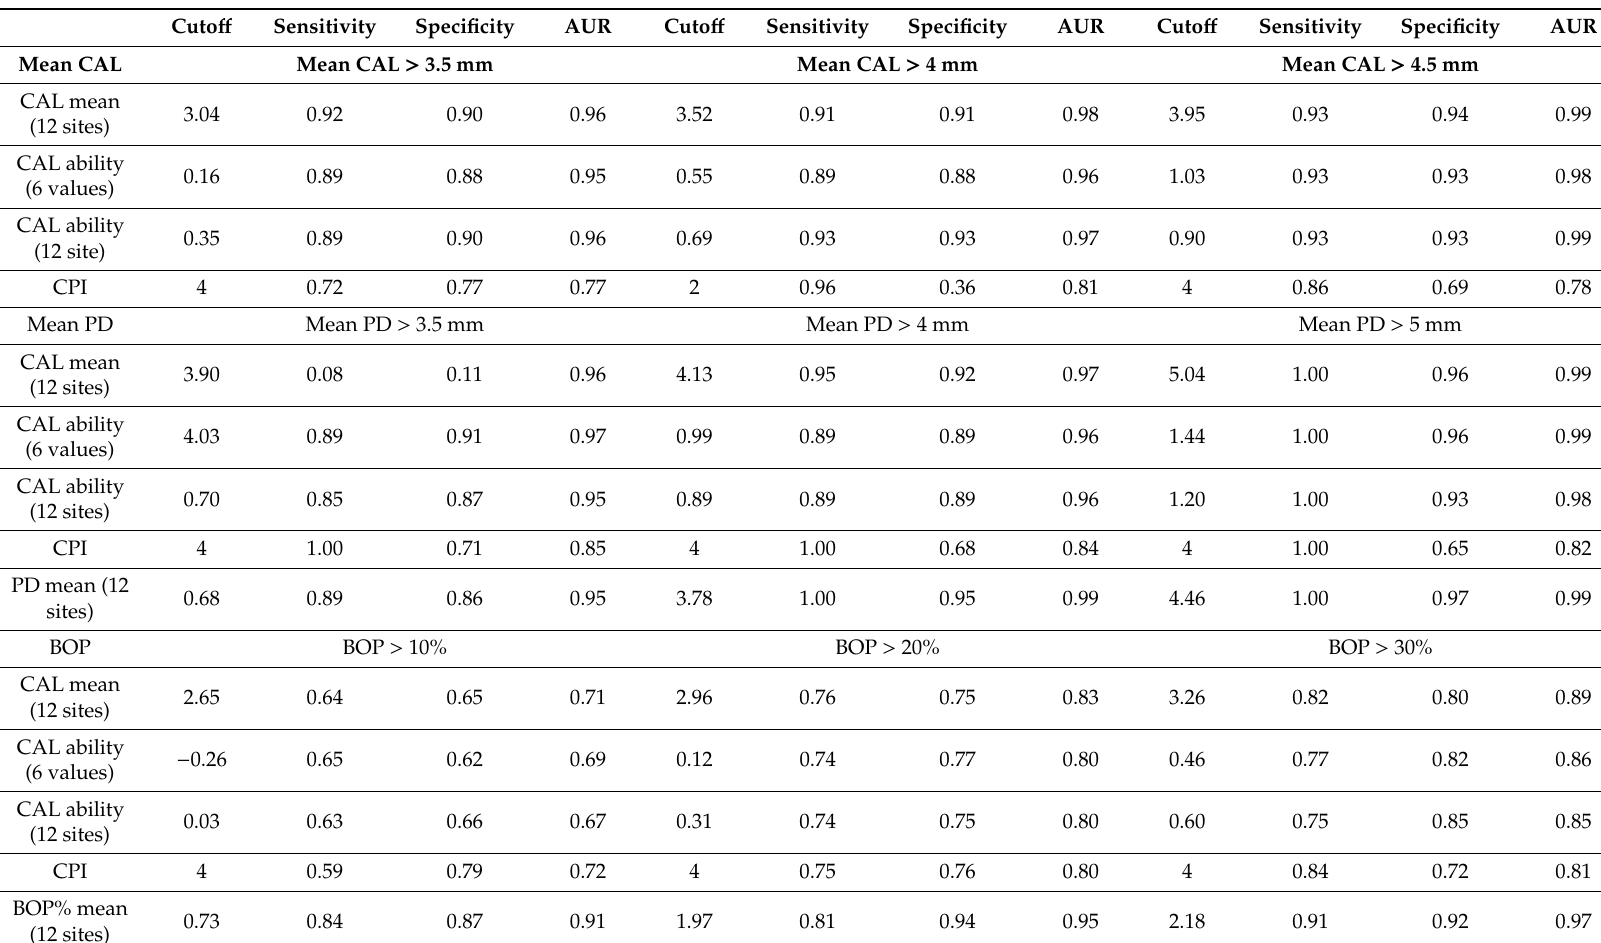
Table 4. Receiver operating characteristic curve analysis of the selected optimal examination sites for the mean values of pocket probing depth, clinical attachment level, and bleeding on